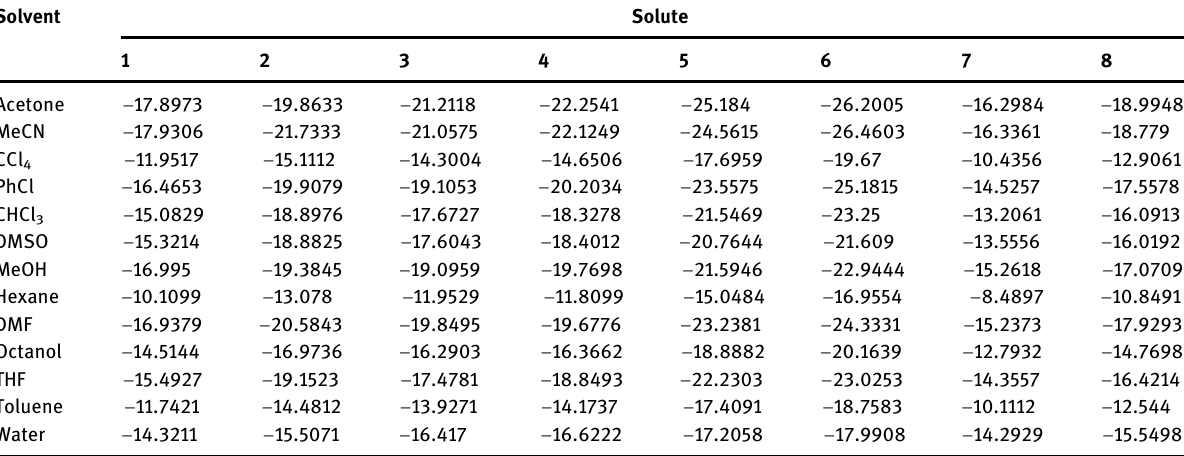
Table 5: Solvation free energies ( kcal/mol ) calculated using SMD solvation model and M062XL functional; hexane ( n - hexane ) , CCl 4